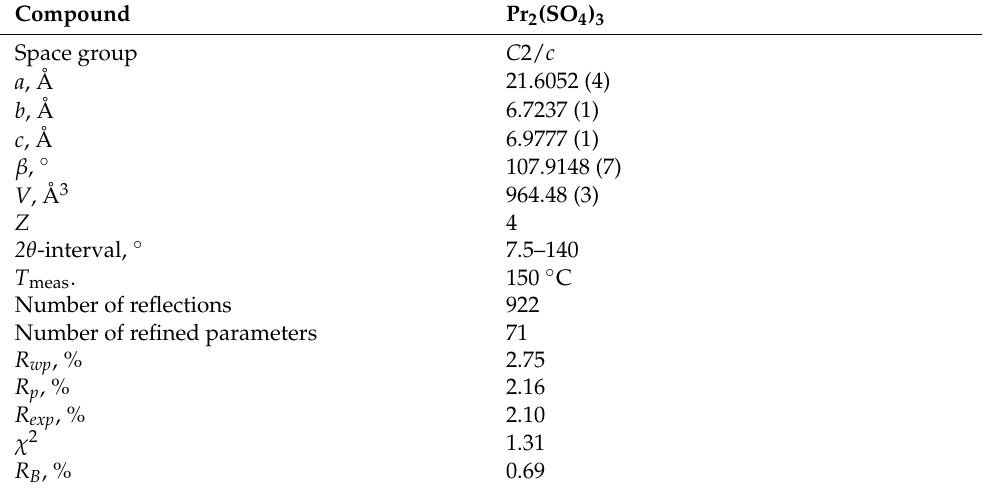
Table 1. Main parameters of processing and refinement of the Pr 2 (SO 4 ) 3 sample.